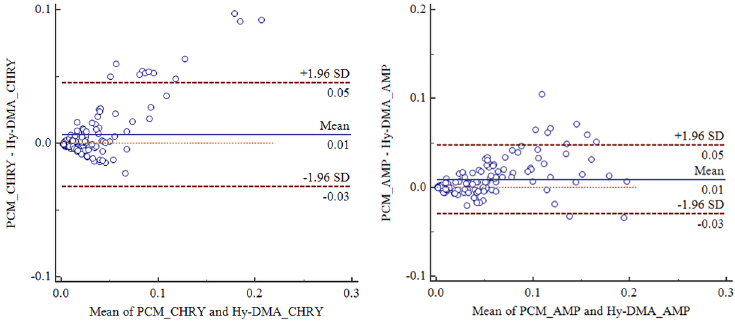
Fig 11. Comparison of KOFAM and PCM methods using a Bland & Altman